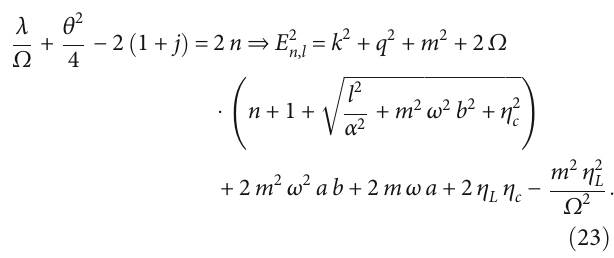
We plot graphs of the above energy eigenvalues w. r. t. dif- ferent parameters. In Figure 1, the energy eigenvalues E 1 , 1 against the parameter η . In Figure 2, the energy eigenvalues c . In Figure 3, the energy eigen- E 1 , 1 against the parameter η L values E 1 , 1 against the parameter M . In Figure 4, the energy eigenvalues E 1 , 1 against the parameter ω . In Figure 5, the energy eigenvalues E 1 , 1 against the parameter Ω .